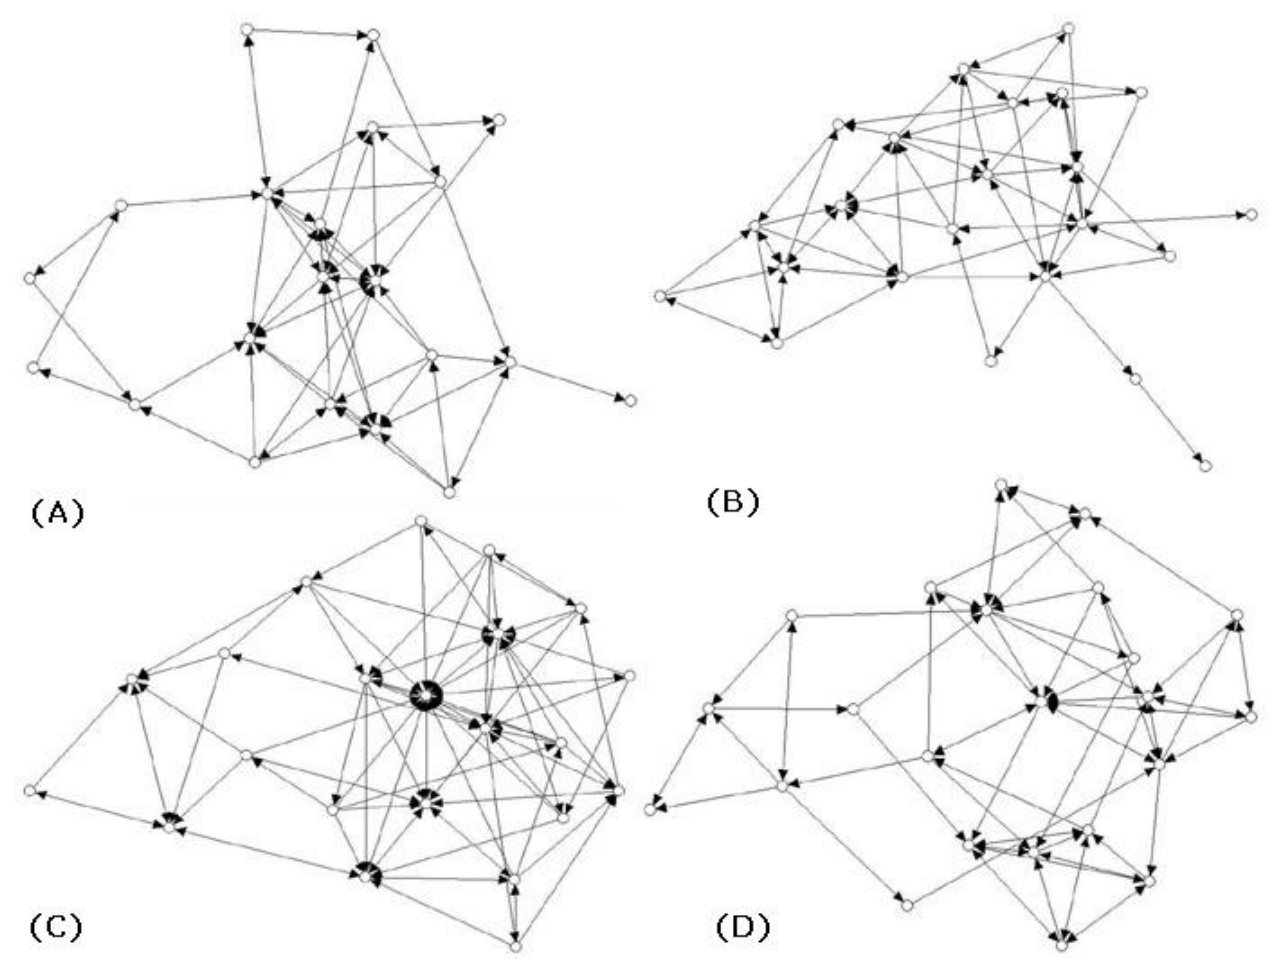
Fig. 1. Socio-grams for community networks (A) 1, (B) 2, (C) 3, and (D) 4. Nodes represent individual farmers and directed arrows represent advice